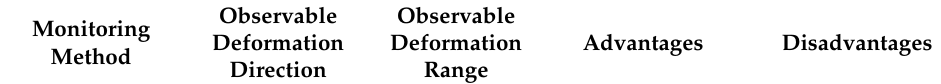
Table 2. Comparison of the satellite, UAV, and ground survey techniques used in this